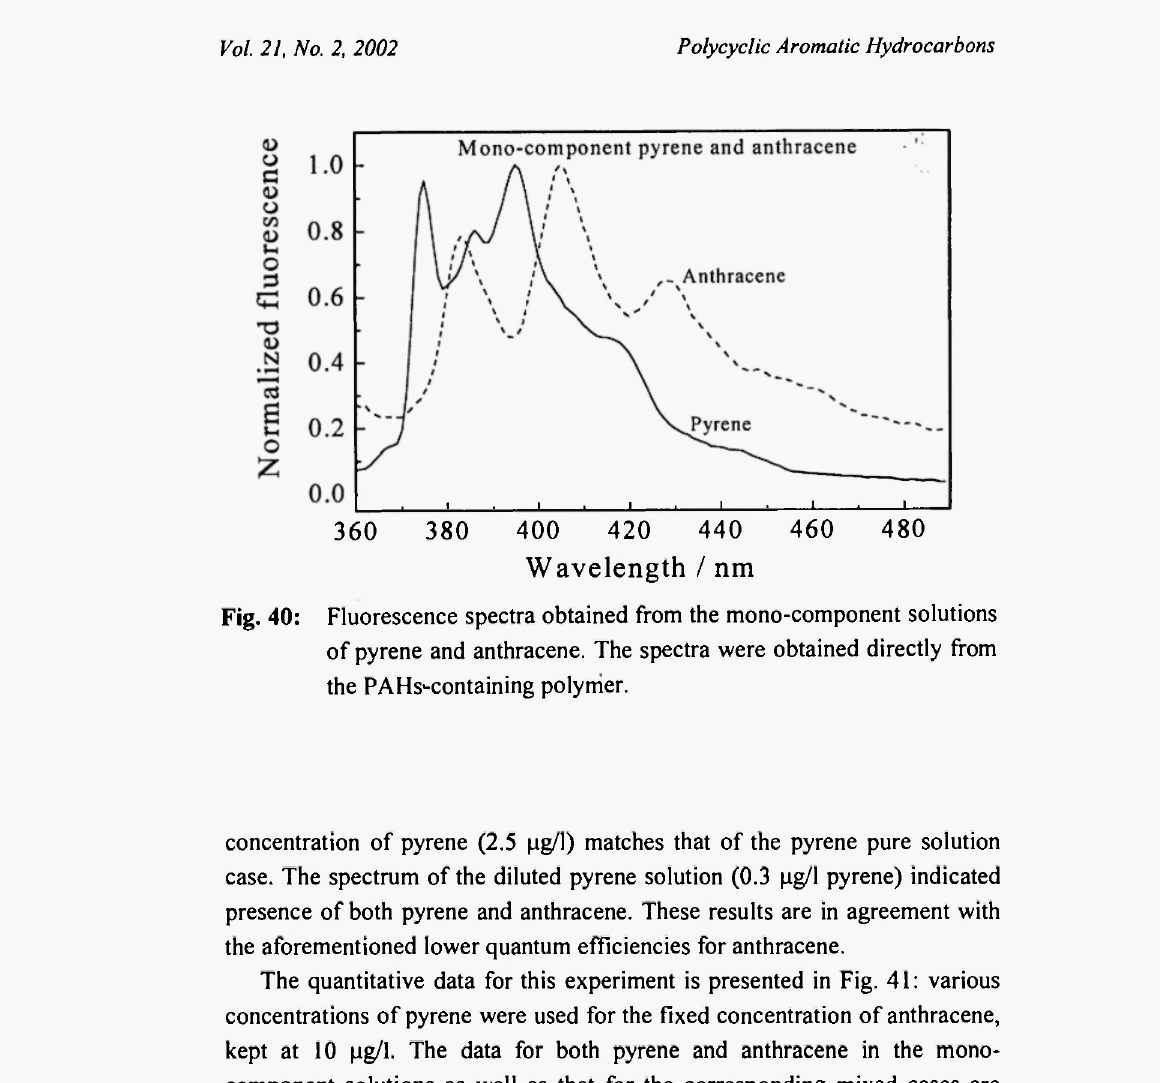
Fig. 40: Fluorescence spectra obtained from the mono-component solutions of pyrene and anthracene. The spectra were obtained directly from the PAHs-containing